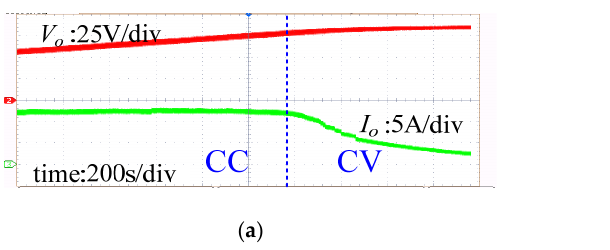
Execution Cycle Calculation Time